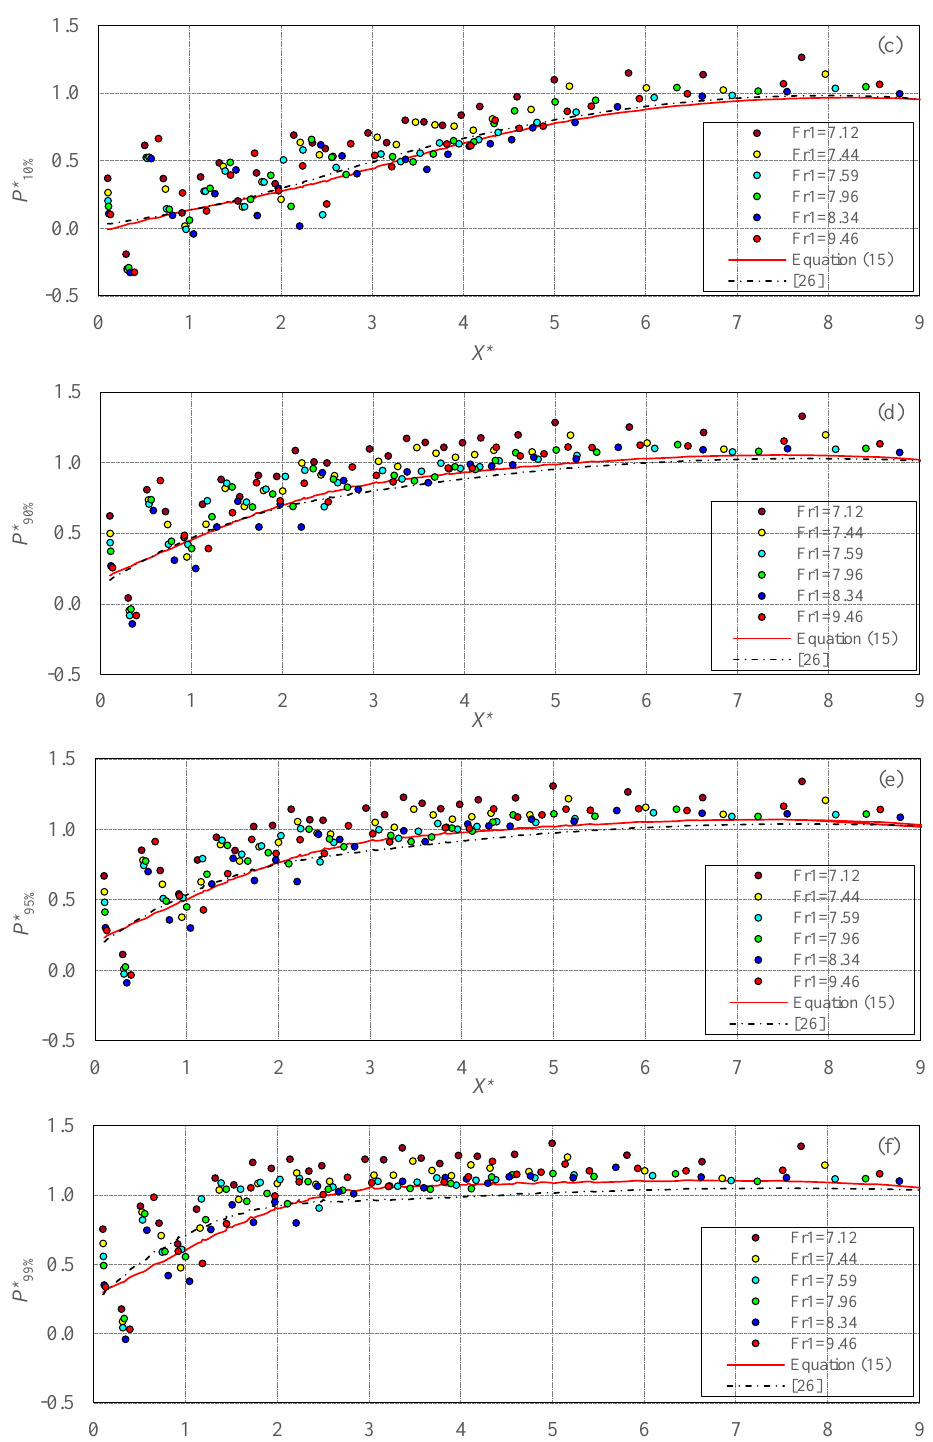
Figure 10. Distributions of P *k% with different probabilities: (a) P * 1% , (b) P * 5% , (c) P * 10% , (d) P * 90% , (e) P * 95% , and (f) P * 99% .